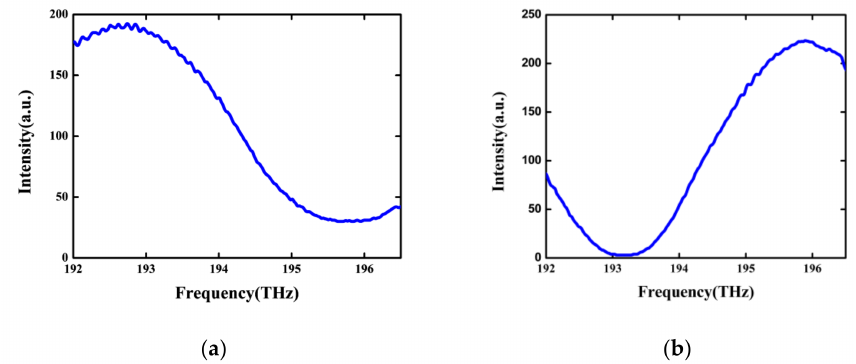
Figure 5. Reflection spectra of the fiber FP sensors for cavity lengths of ( a ) 20.16 µ m and ( b ) 28.90 µ